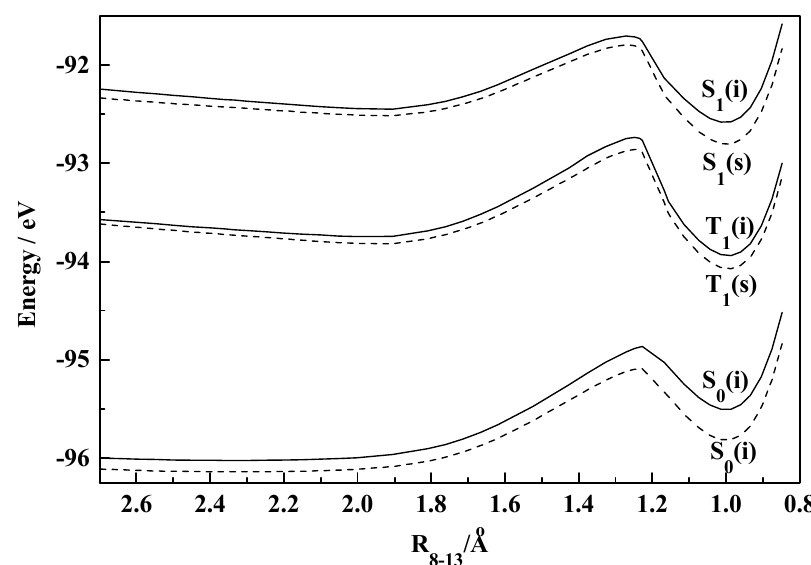
Figure 11. Simulated PECs for IPT process of HPI in S ethanol).